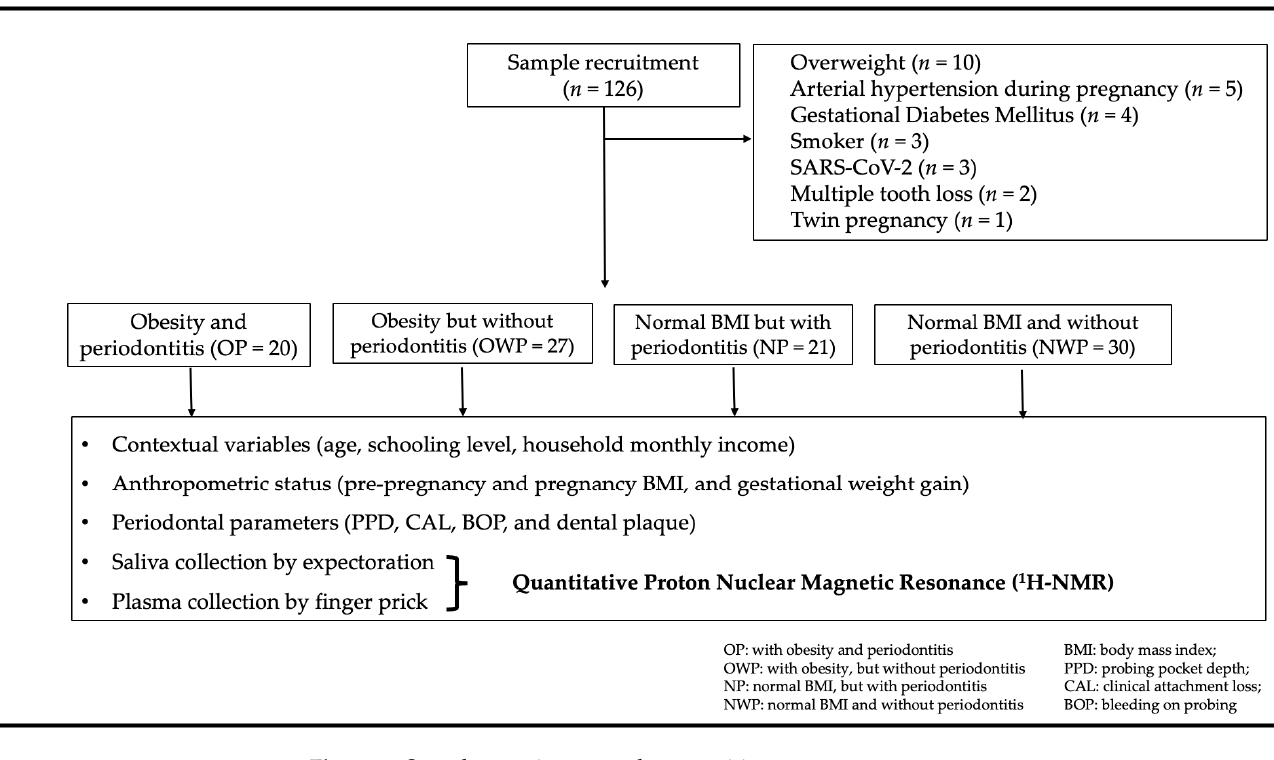
Figure 1. Sample recruitment and